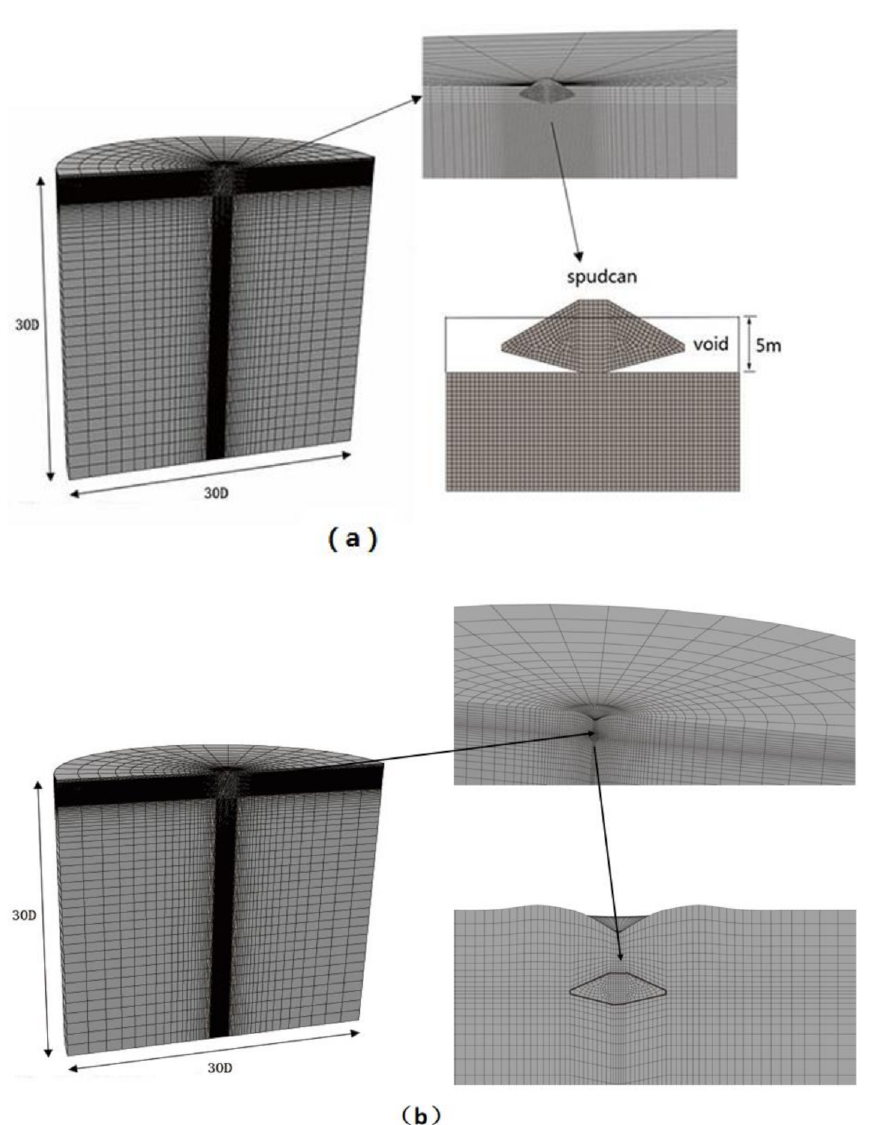
Figure 3. Finite element model for a typical LDFE (large deformation finite element) computation with DSEL (dual-stage Eulerian–Lagrangian) technique (Spudcan-IV): (a) Eulerian finite element model, (b) Lagrangian finite element